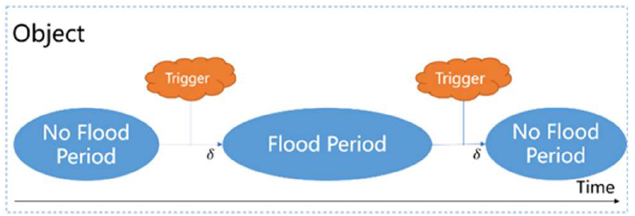
Figure 5. Schematic diagram of the presentation results of object-level dynamic expression classes.